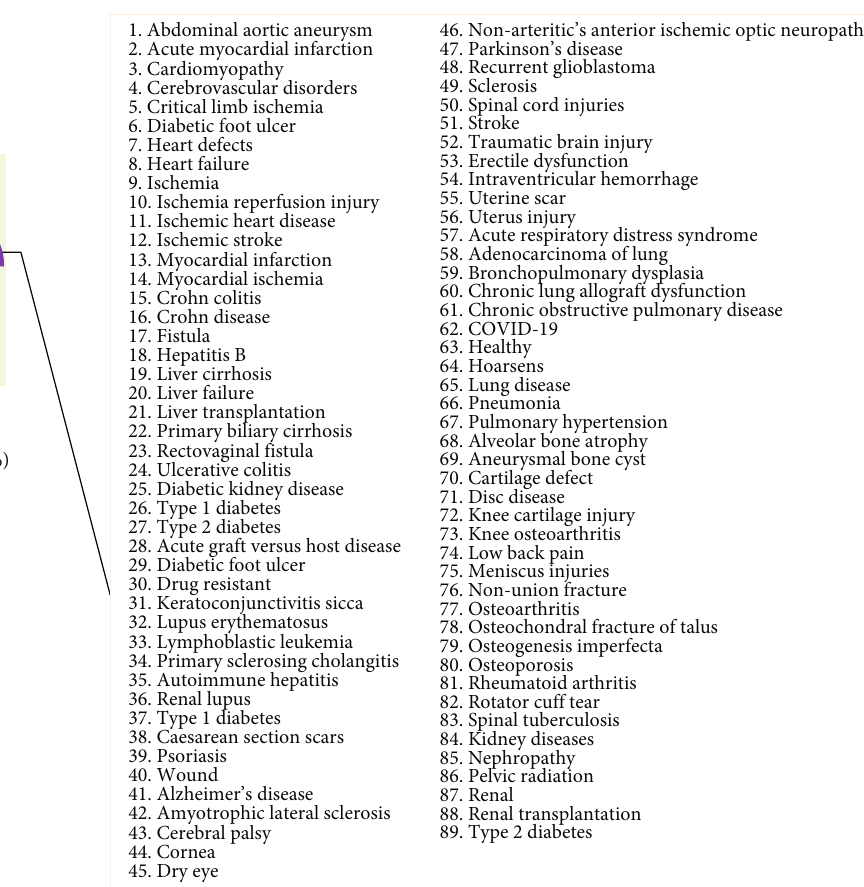
Figure 2: An overview on statics relating to MSC-based therapy clinical trials obtained from the U.S. National Library of